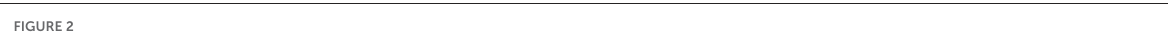
FIGURE2 color coding changes from purple to orange to yellow. Parts labeled with 1 are HV with mean global T1 of 1,162ms. Parts labeled with 2 show a HD patient with a Qa of 1,215 ml/min. Mean global T1 is significantly increased at 1,208ms with a septal T1 of 1,221ms compared to HV. Parts labeled with 3 and 4 are HD patients with Qa of 2,310 ml/min and 2,680 ml/min. Mean global T1 further increased at 1,327ms and 1,375ms, with septal T1 of 1,340ms and 1,380ms. (B,C) There is a discrete differentiation in global and septal T1 times among HV, HD with a low Qa and HD with a high Qa.